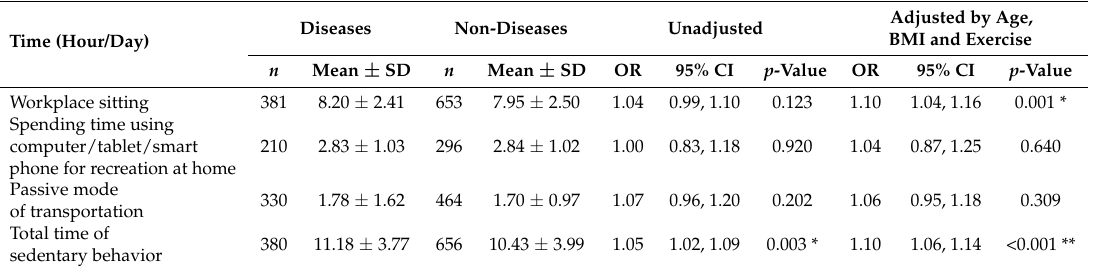
Adjusted by Age, BMI and